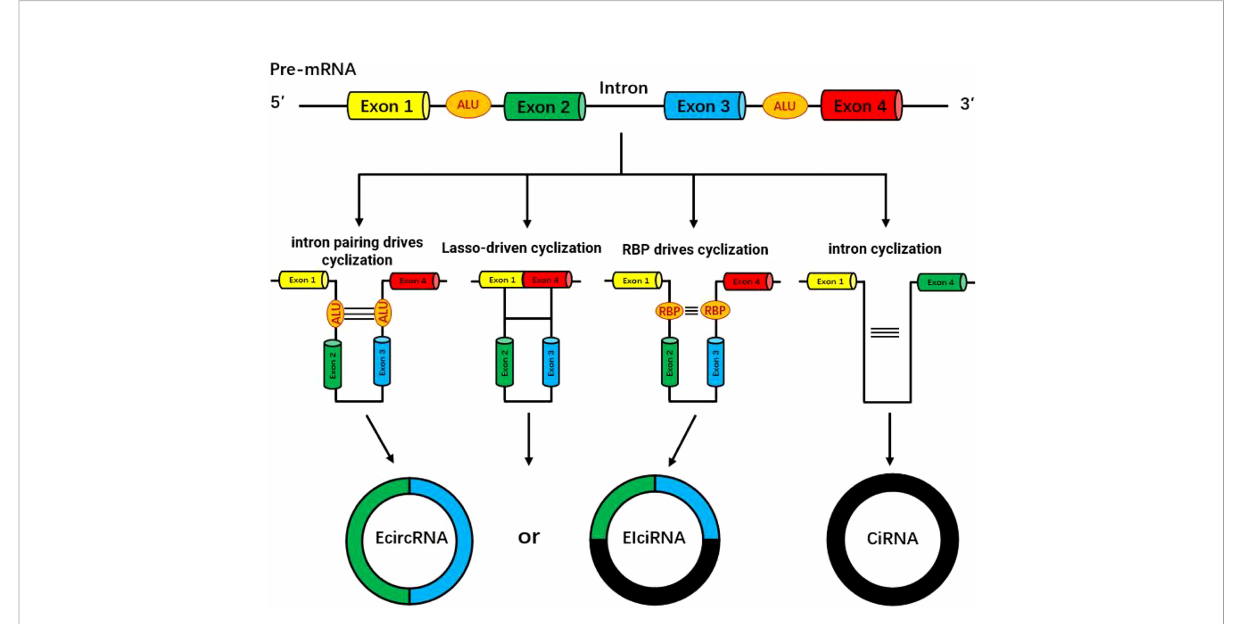
FIGURE 1 The formation and regulatory mechanism of